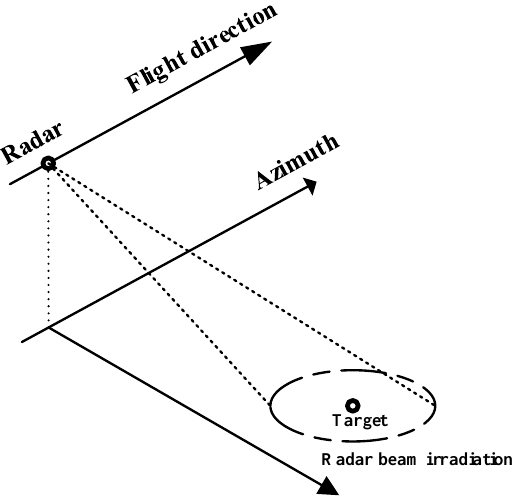
Figure 1. Synthetic aperture radar (SAR)